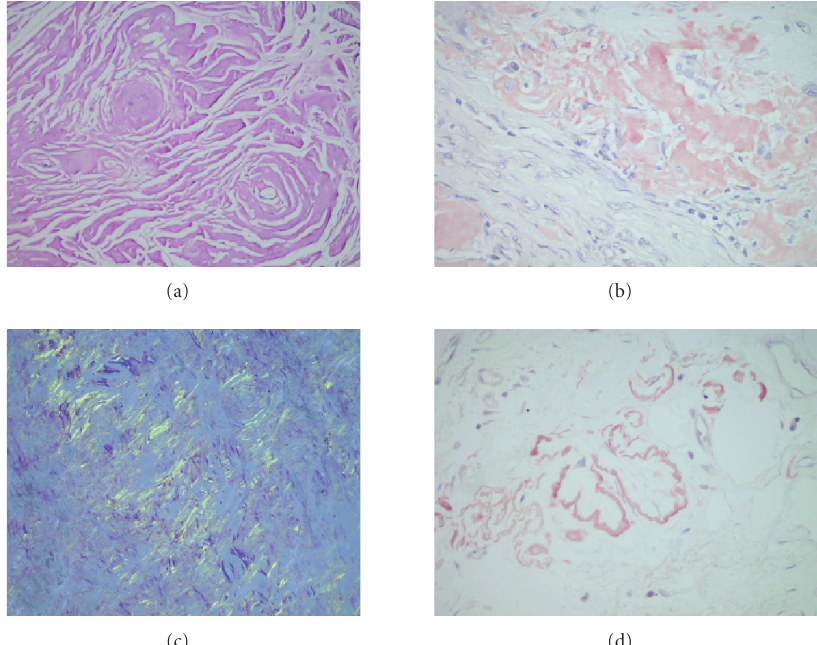
Figure 3: (a) Closer view of amorphous, fibrillary matrix deposition (hematoxylin and eosin, × 20). (b) Peach-red staining of the material in Congo-red staining (Congo-red, × 20). (c) Apple-green birefringence under polarized light (Congo-red, polarization microscope, × 20). (d) Amyloid deposition in vessel walls (Congo-red, × 20).